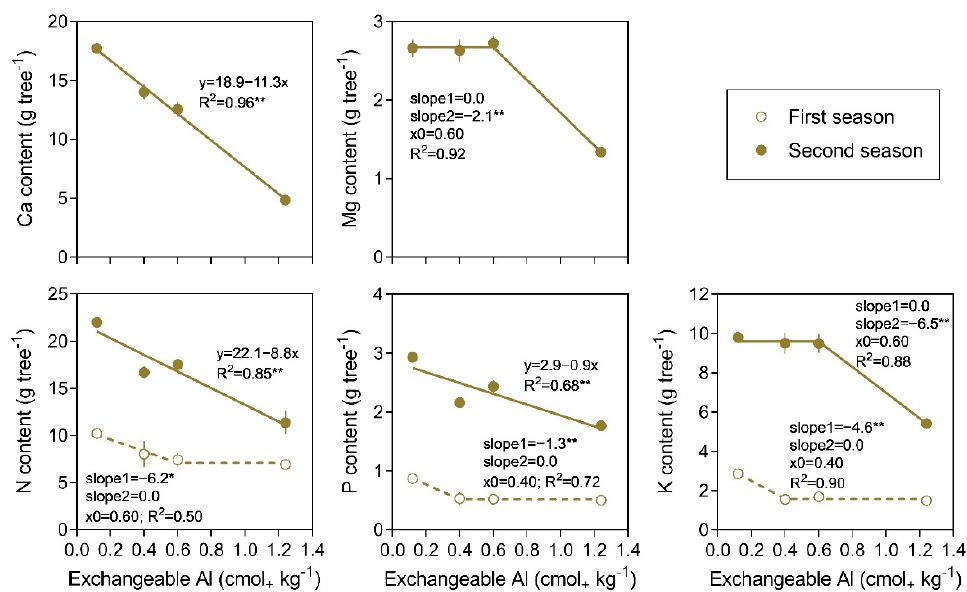
Figure 7. Relationship between total N, P, K, Ca, and Mg contents in sweet cherry trees and ex- changeable Al in a volcanic soil. Values are the means, with standard errors as vertical bars ( n = 3). Significance of slopes: * p < 0.05; ** p < 0.01. In segmental regression, slope1 is the slope of the first line segment, slope2 is the slope of the second line segment, and X0 is the X value where the two line segments intersect.